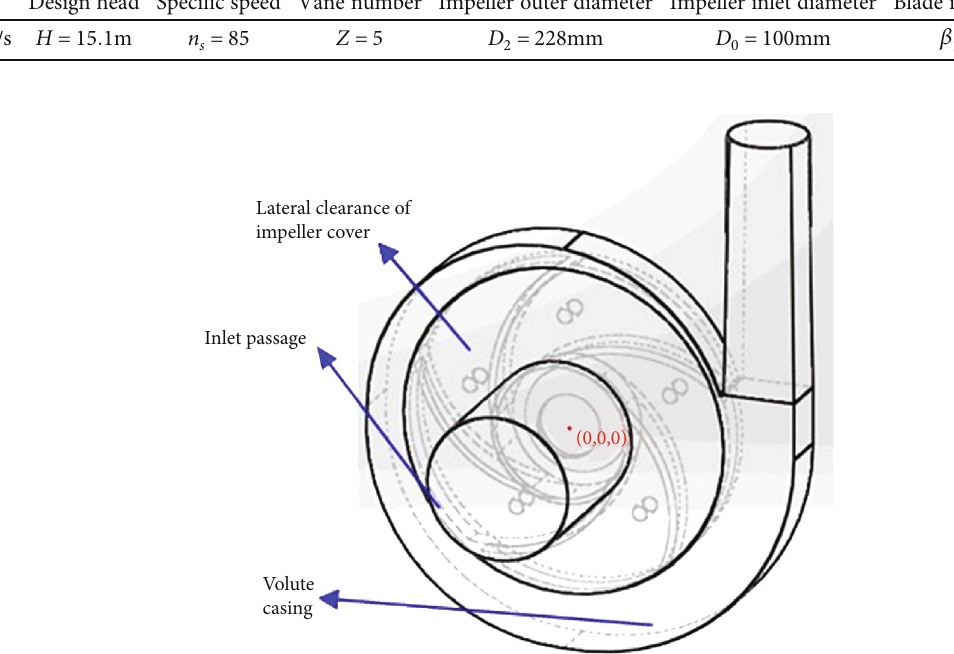
Figure 1: The whole fl ow fi eld model (Shi et al.